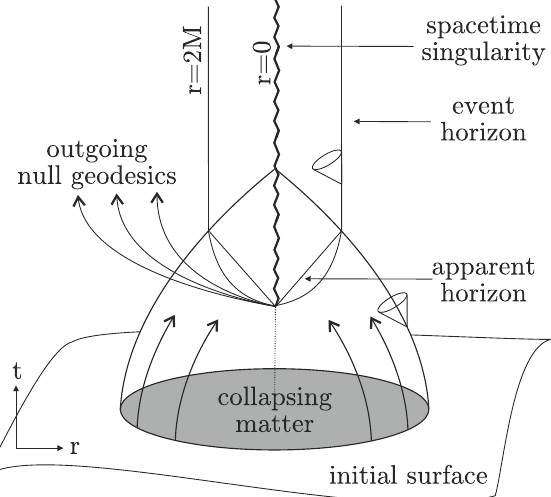
Fig. 3 Inhomogeneous dust collapse: a space–time singularity, which is formed from an inhomogeneous, spherically symmetric dust collapse, can be visible to external observers in the universe, in violation to both the weak and strong cosmic censorship conjectures. The picture is taken from